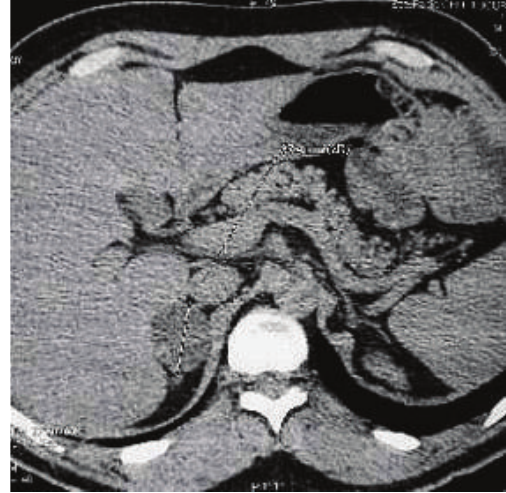
Figure 2: CT scan of the abdomen demonstrating a 2 . 5 × 4 . 0 cm mass in the right adrenal gland.